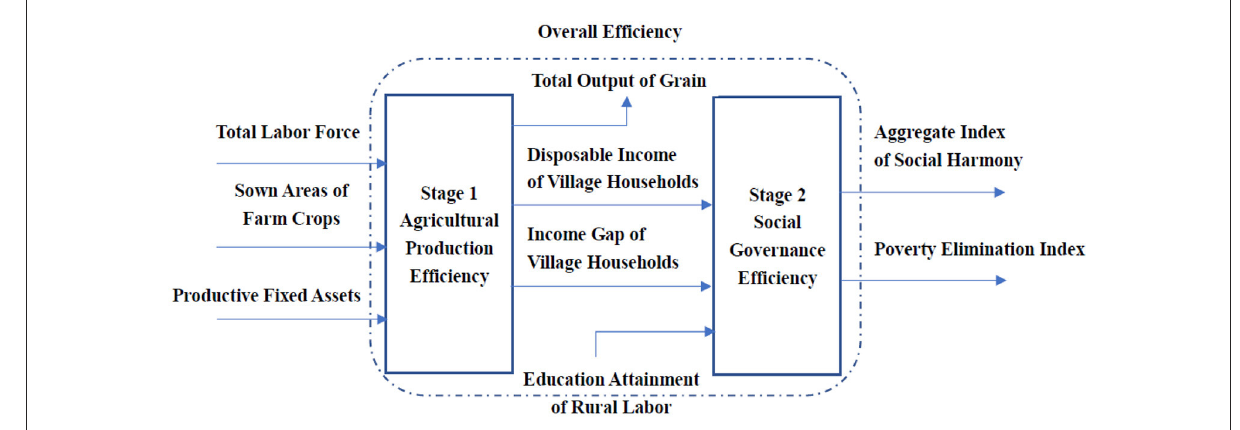
FIGURE1 Theoretical analysis framework for two-stage agricultural poverty